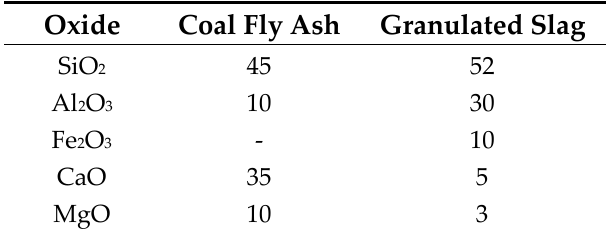
Table 2. Oxides compositions of coal fly ash and granulated slag in